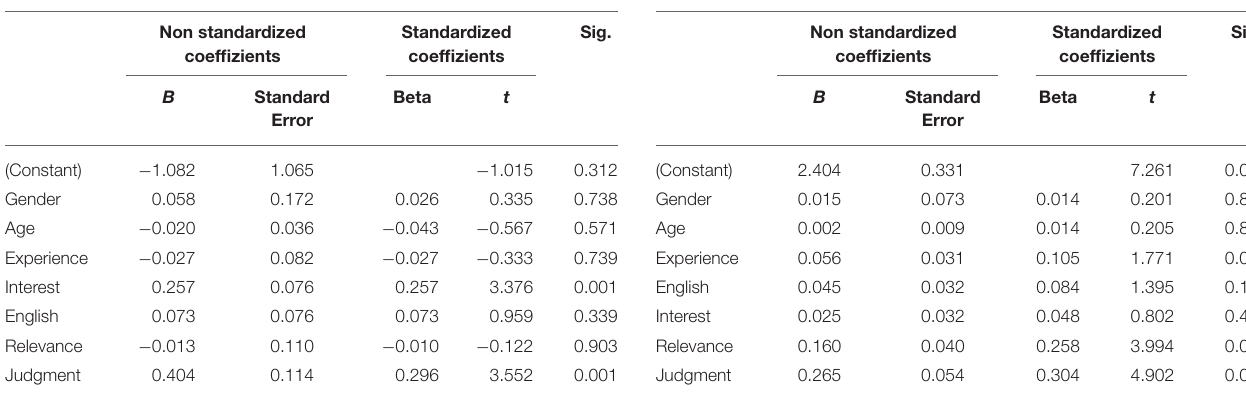
TABLE 7 | Linear regression model predicting the score on the UN-scale in the Nigerian